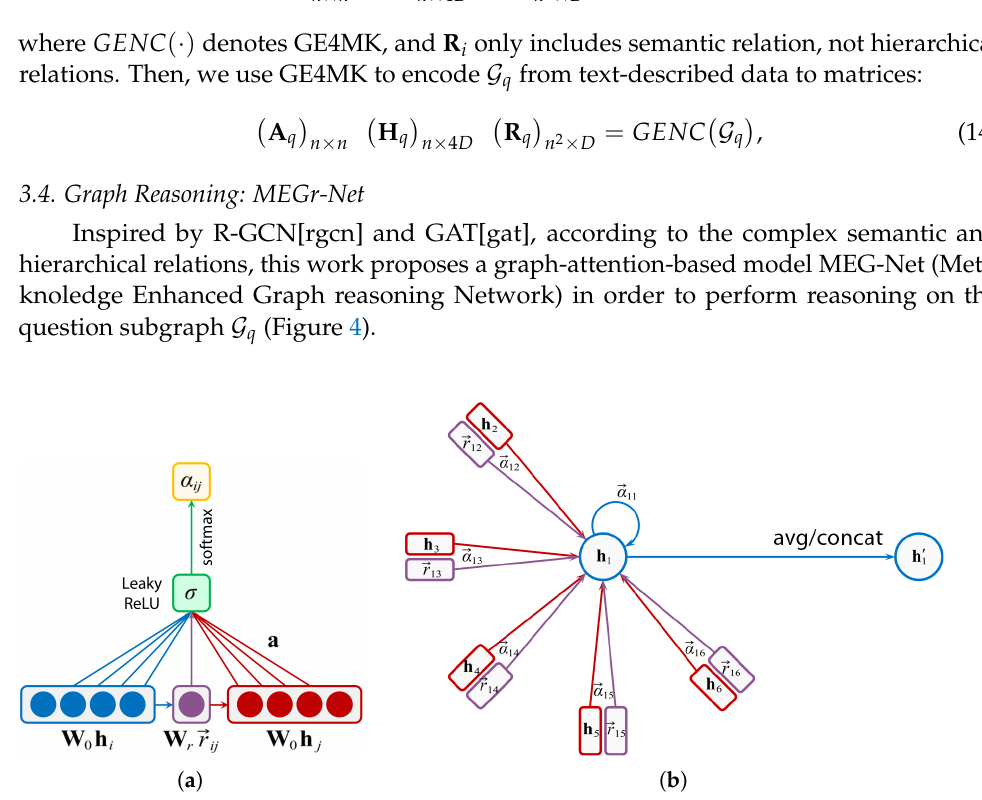
Figure 4. The attention mechanism of MEGr-Net. ( a ) Self-attention; ( b ) attention aggregation. Relational Graph Attention Layer (R-GAL) is the basic part of MEGr-Net, and the out-